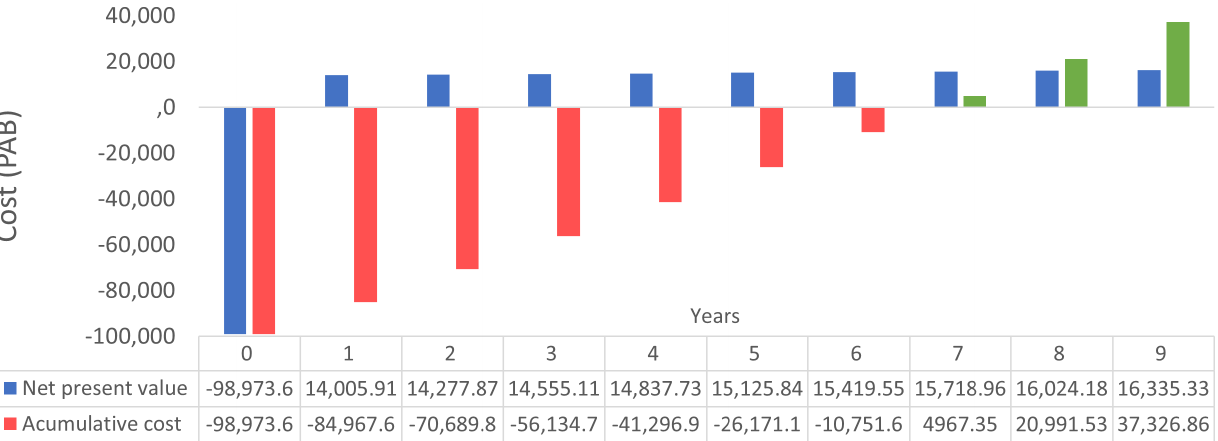
Figure 10. Calculation of the net present value and the return of investment period of the investment for the selected optimal option. The red color represents the years where no profit has been generated, while green is shown from the first year of profit.